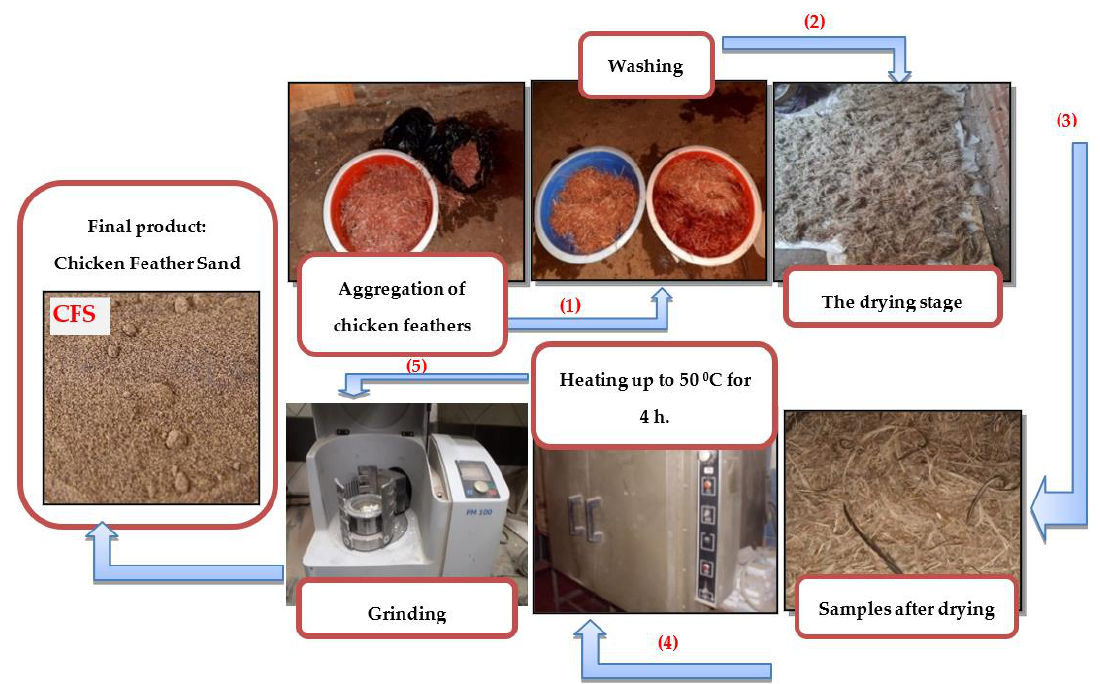
Figure 2. The process of preparing sand from chicken feathers. Figure 3A depicts a photograph of a chicken feather, and Figure 3B shows sand Table 1. Physical properties of the chicken feathers (CFs). (CFS) made from chicken feathers. More than 90% of the protein in chicken feathers is a fibrous and insoluble structural protein. The chicken feather has good resiliency because it has cross - section gaps. Saving money, helping to build a more sustainable environ- ment, and increasing the sand market are all benefits of using chicken feathers. Table 2 shows the elemental composition of a chicken feather (CF).